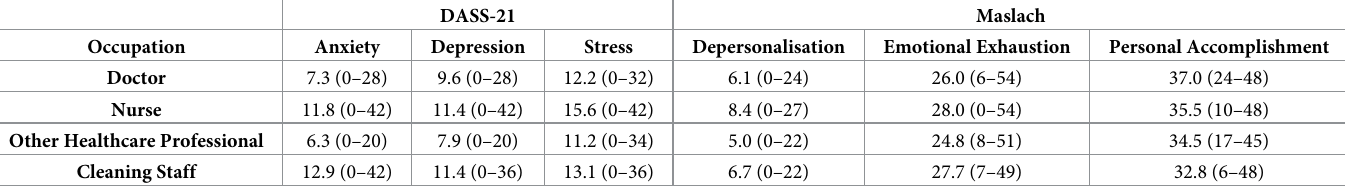
Table 2. Mental health by profession.